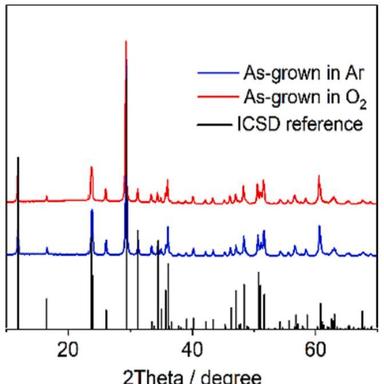
Powder XRD patterns of the as-grown CaNb2O6 single crystals.